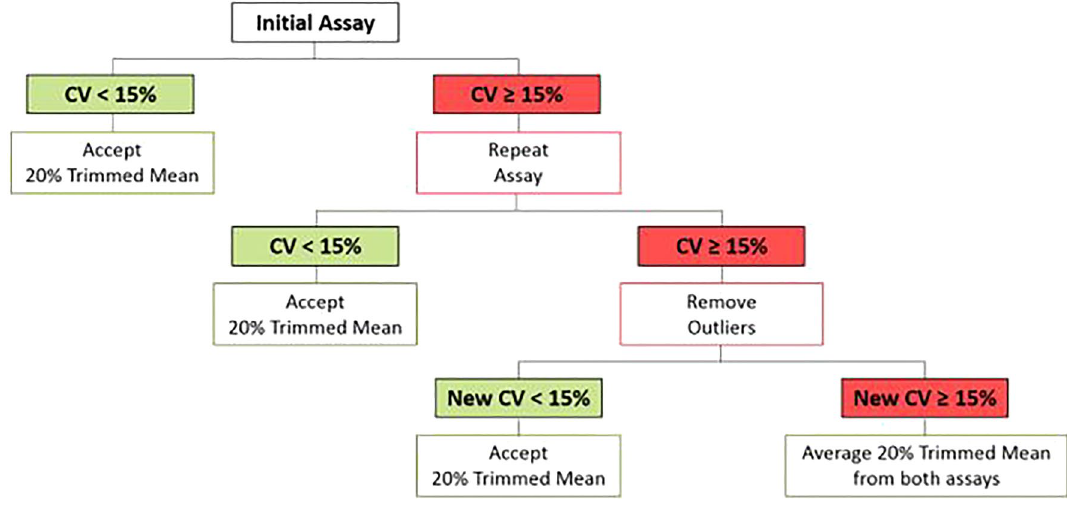
Figure 2. Result acceptance decision